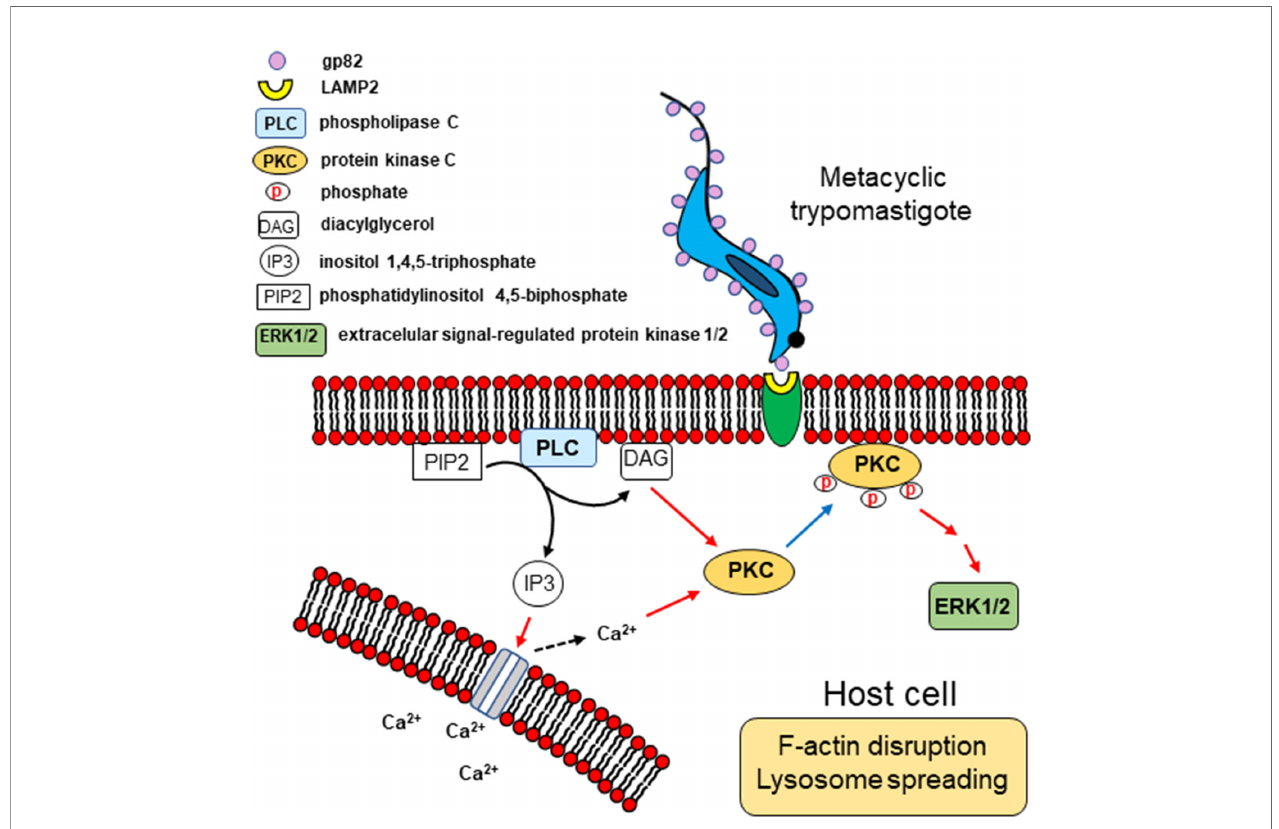
FIGURE 9 | Schematic representation of signaling molecules and pathways possibly activated during T. cruzi MT invasion of HeLa cells. Upon MT gp82 interaction with host cell LAMP2, PLC would be activated, generating DAG and IP3. Then Ca 2+ would be released from IP3-sensitive reservoir. Both Ca 2+ and DAG activate PKC, which translocates to the plasma membrane, and then follows the downstream ERK1/2 activation. This cascade of events is associated with the actin cytoskeleton disruption and lysosome